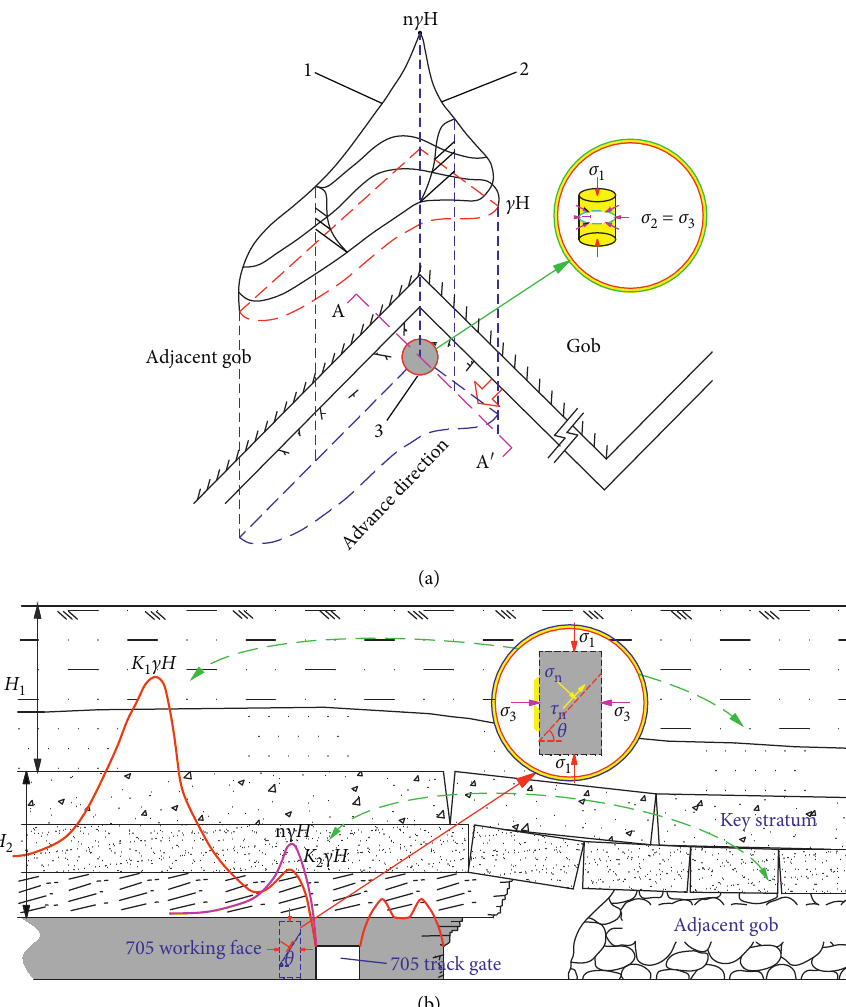
Figure 3: Simplified model of the coal pillar in L-shaped zone: (a) superimposed support pressure of the coal pillar in the L-shaped area; (b) A-A ′